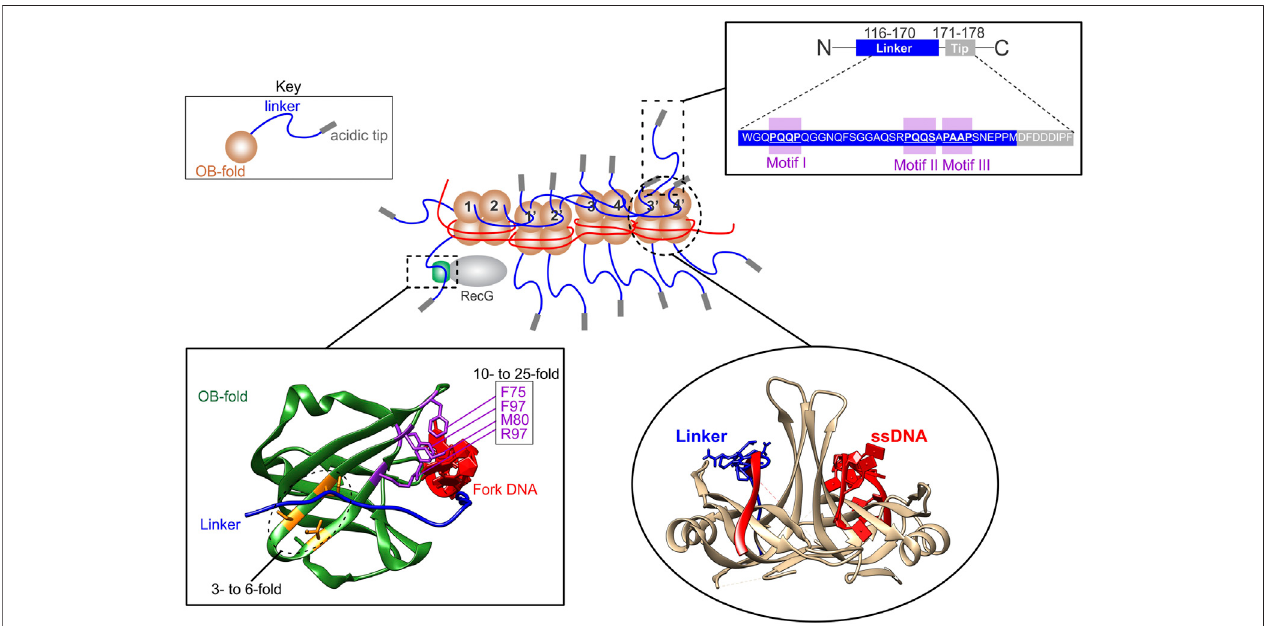
FIGURE6| The SSBinteractomeisregulated bylinker/OB-foldbinding. Asection ofanSSB-ssDNAcomplex isshown inthe center. Within thiscomplex,the OB- folds (light brown) of some subunits are bound to ssDNA (red) while others bind to the linkers (blue) of adjacent SSB monomers. The regions of the linker responsible for mediatingOB-foldbindingarethePXXPmotifs(inset,upperright).WhenboundtossDNA,thelinkersofmonomers1and2,bindtotheOB-foldsofmonomers1 ′ and2 ′ , respectively.Concurrently,thelinkersofmonomers1 ′ and2 ′ bindtotheOB-foldsofmonomers3and4,andtheirlinkersbindtomonomers3 ′ and4 ′ ,respectively. The ability of ssDNA and a peptide corresponding to the linker of SSB to bind to SSB OB-folds was initially shown using molecular modeling [lower right inset; (Bianco 2017)] and later by experiments [details in the text; (Ding et al., 2020)]. SSB linkers also bind to the OB-fold of partners as shown for RecG bound to the SSB-ssDNA complex with the structure of the RecG OB-fold in the lower left inset. Here the OB-fold is shown in green with relevant residues coloured in purple and orange. When mutated, residues in purple result in a 10- to 25-fold reduction in SSB binding in vivo , whereas those in orange result in only a 3- to 6-fold reduction (Ding et al.,